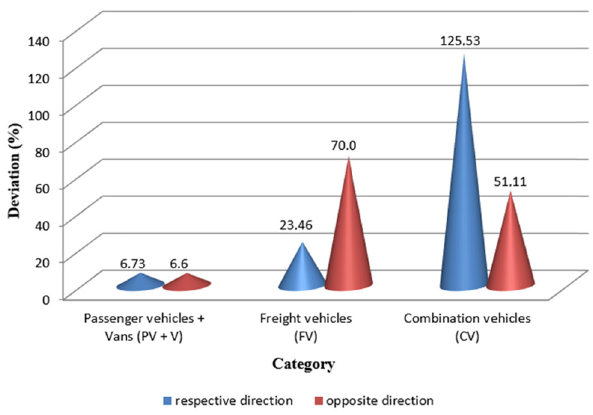
Figure 4: Speedometer deviation for the individual vehicle cate - gories ( 1st survey ) .